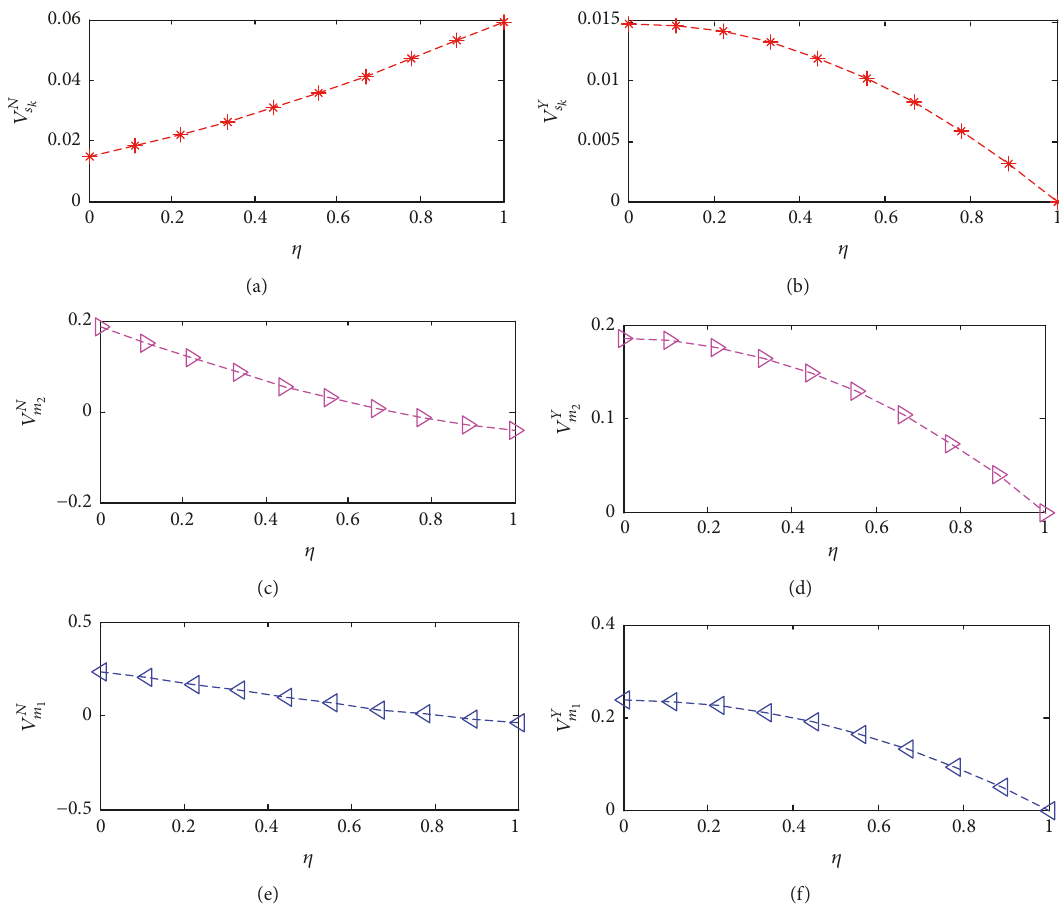
Figure 3: The impact of 𝜂 on 𝑉 𝑁 𝑠